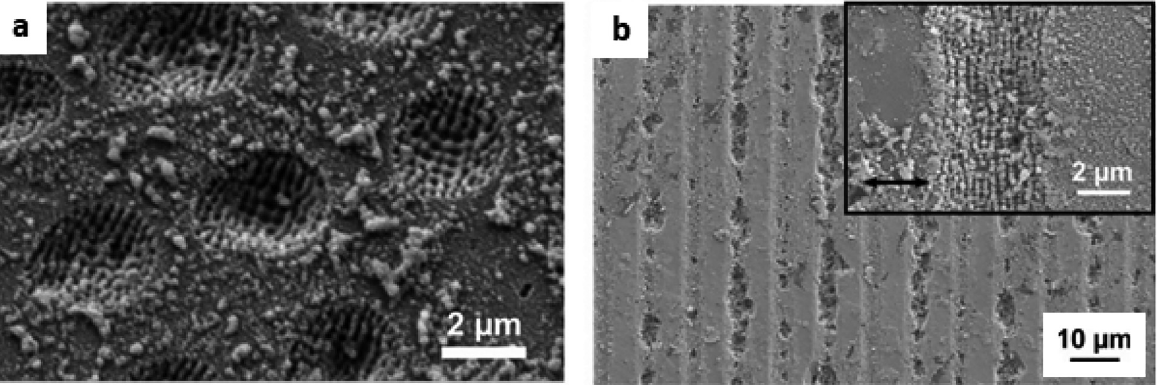
Figure 19: Microstructured sodalime glass by ps-laser radiation in the visible (532 nm) with (a) four and (b) two overlapping beams. In both cases LIPSS can be seen on the glass surface. The inset in (b) shows LIPSS aligned perpendicular to the laser polarization direction (double arrow). Reproduced from ref. [176] (Licensed under a Creative Commons